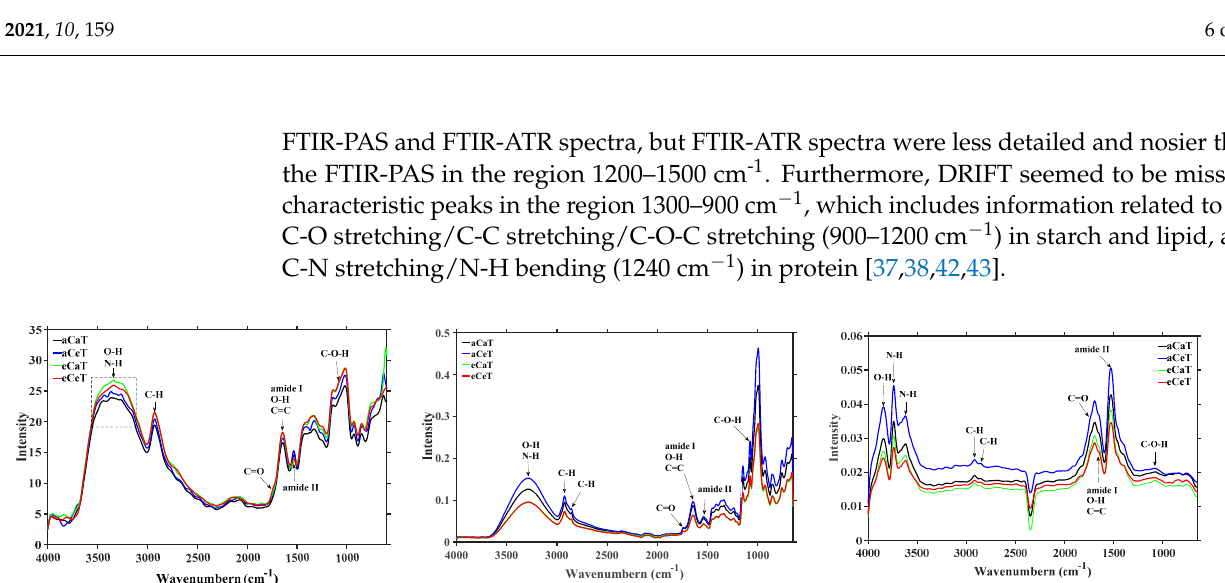
Table 1. Assignment of the main bands of the FTIR spectra of the rice samples. FTIR-PAS FTIR-ATR